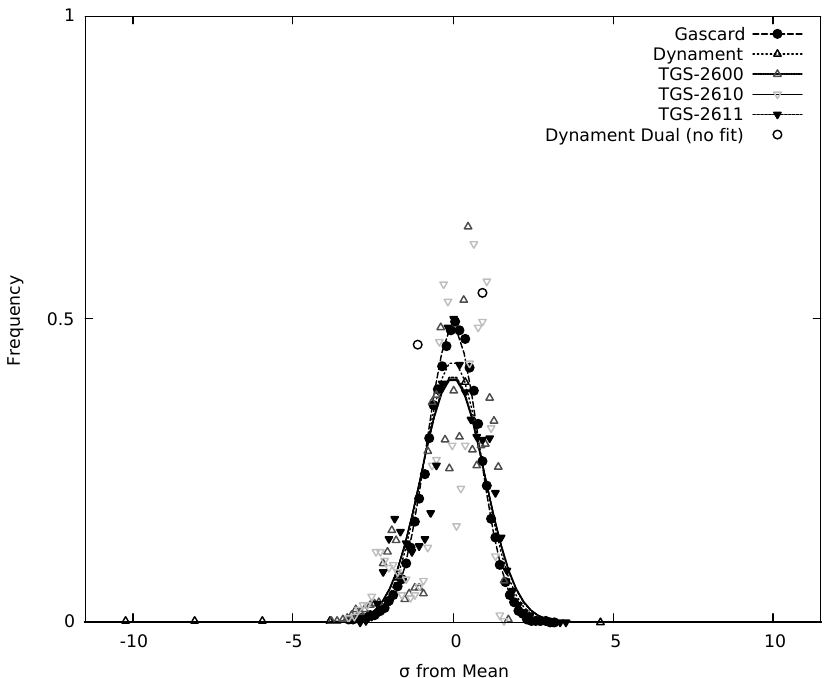
Figure 7. Frequency distribution of the digitized sensor output around the mean response of the sensor (points), along with Gaussian non-linear fit for each CH sensor around the typical environmental 4 baseline concentration of 0 ppm. Any deviation between the center of the Gaussian fit and the mean are due to significant asymmetry of the frequency distribution around the